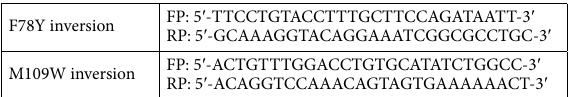
Table 2. Primers used in construction of human MRGPRX2